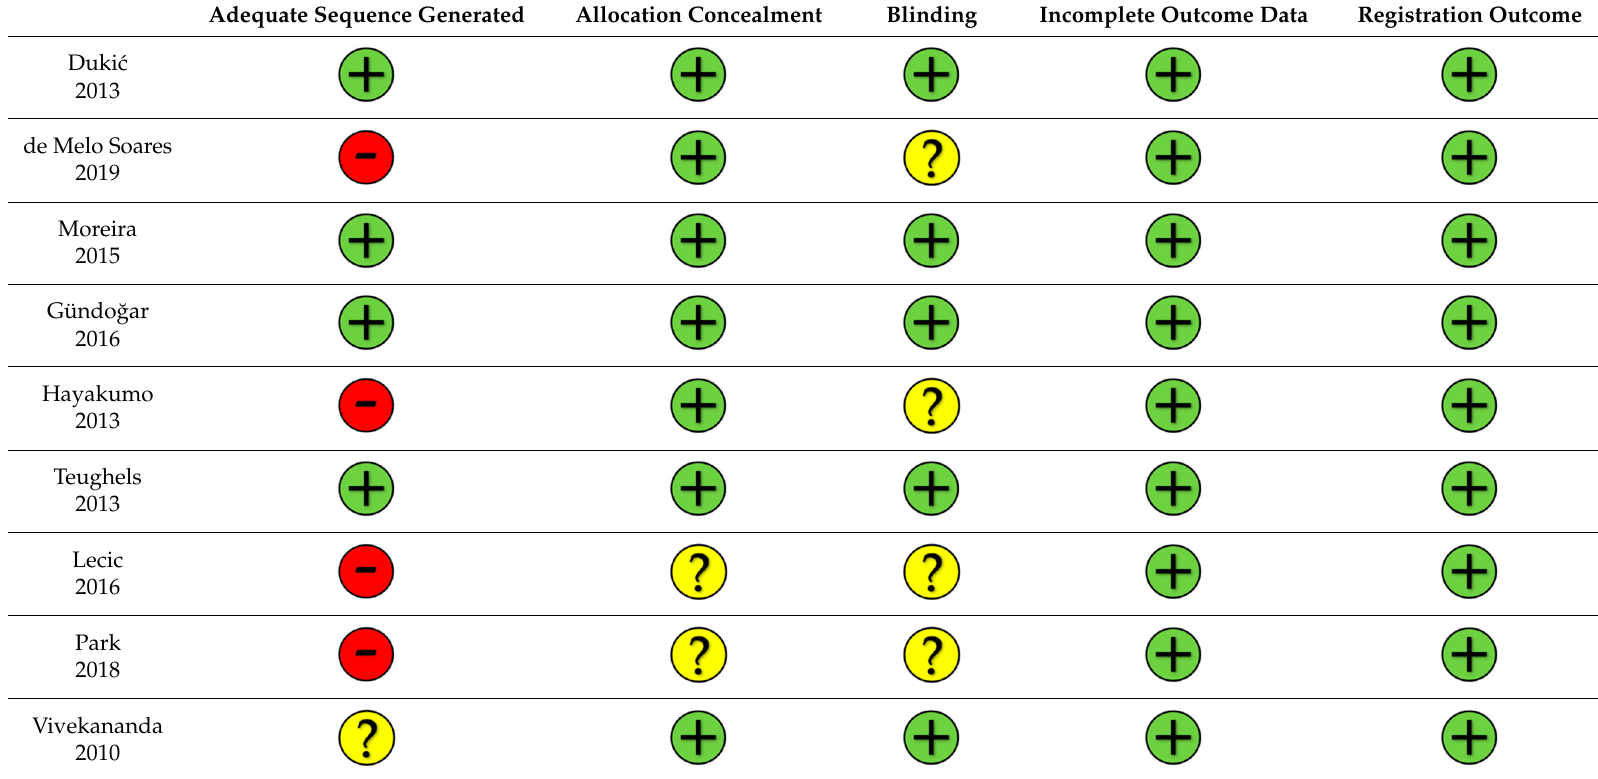
Green symbol: Low risk of bias; Yellow symbol: Moderate risk of bias; Red symbol: Elevate risk of bias.